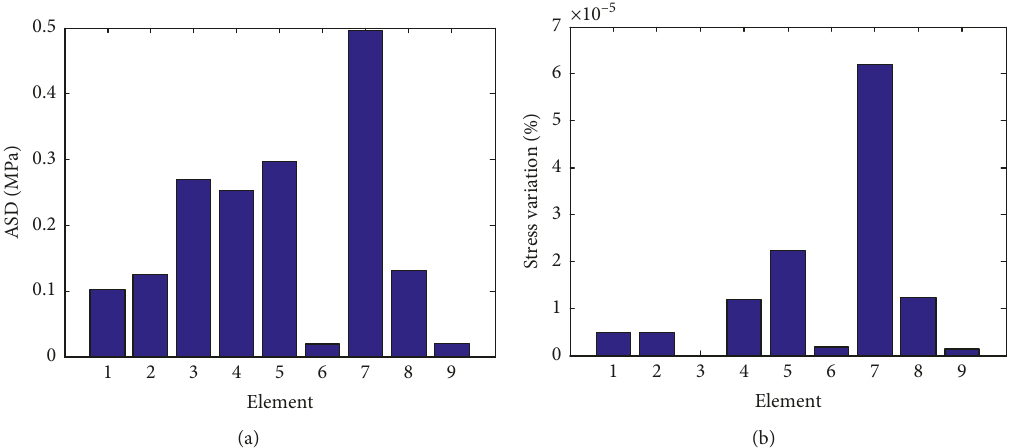
Figure 4: A single damage at element ③ using 5% noise displacements using the global-based approach of (a) ASD and (b) stress change rate.